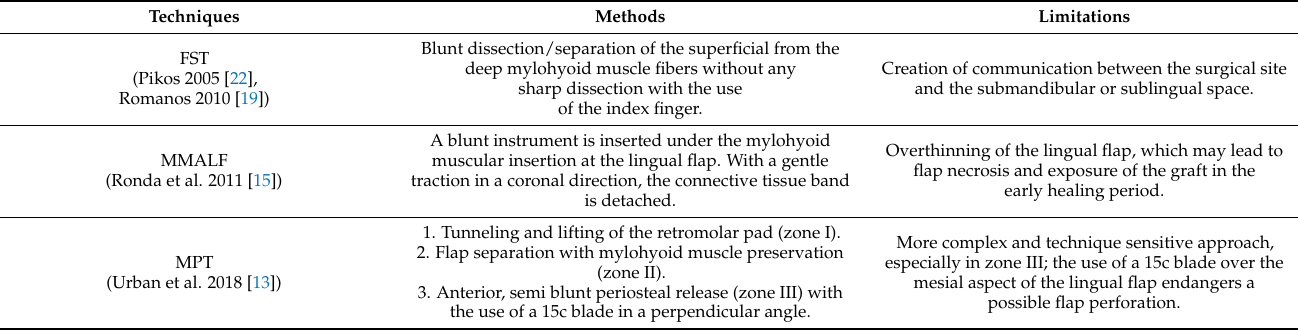
Figure 5. View of the superficial fibers and the attachment of the mylohyoid muscle to the mandible, forming the floor of the mouth: clinically ( a ) and in a human cadaver model [( b )-red arrows]. Three different techniques have been described in the literature regarding the lingual flap management using the MMR (Table 1): (i) Finger sweep technique (FST), (ii) the release of the mylohyoid muscle attachment on the lingual flap (MMALF), and (iii) the mylohyoid preservation technique (MPT) in three key anatomical zones [13,15,22,27]. Table 1. Summary of all three techniques for MMR.